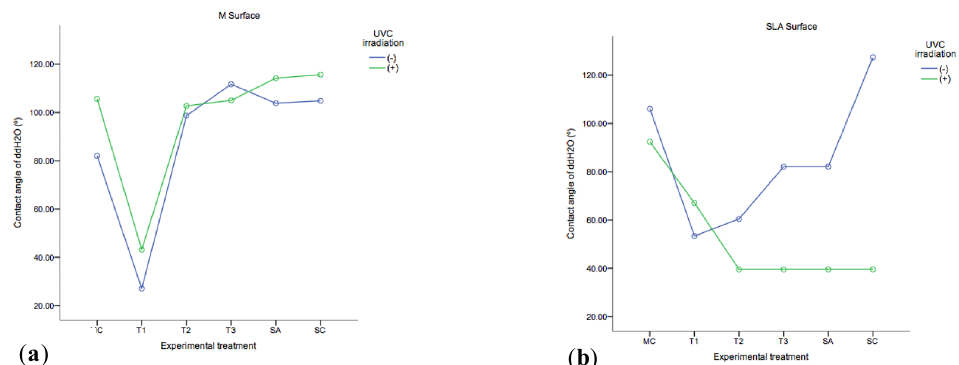
Figure 3. Contact angle of ddH 2 O on Machined ( a ) and SLA ( b ) substrate across control (MC, SA, SC) and experimental (T1, T2, T3) protocols +/ − UVC irradiation. Each circle represents the mean and error bars the 95% CI ( n = 3).